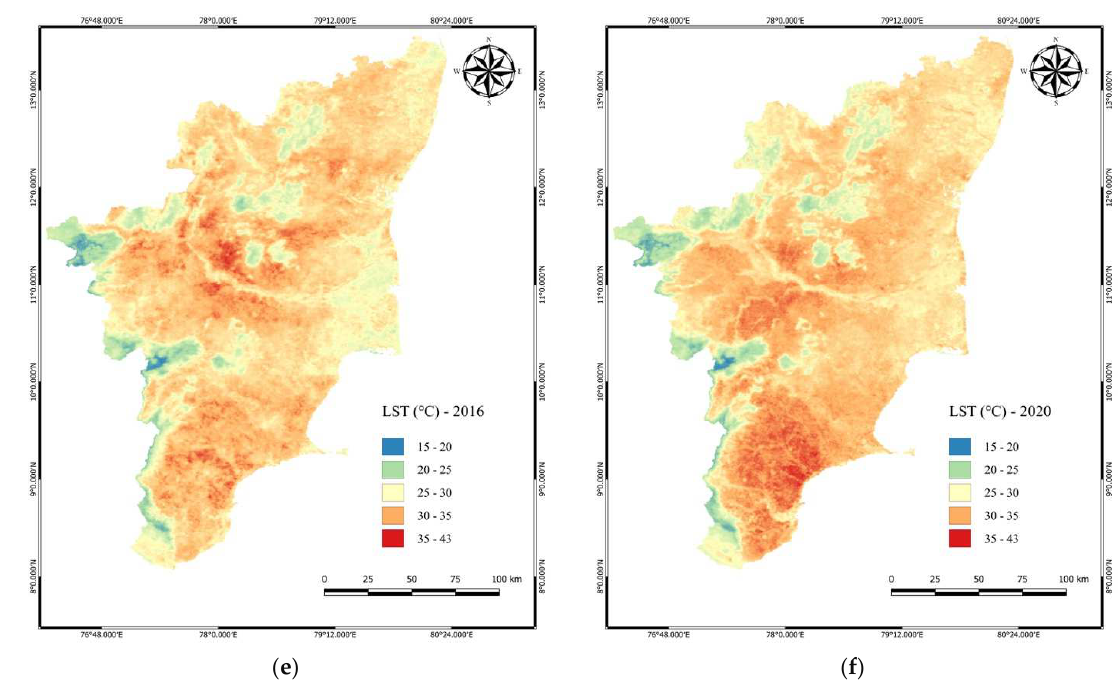
Figure 6. LST map for Tamil Nadu representing the terrain temperature over two decades ( a ) 2000, Table 8. Change analysis of LST for Tamil Nadu for two decades between 2000–2020.